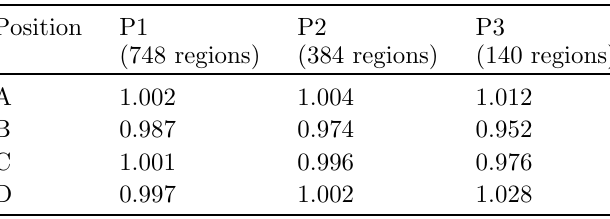
Table 6. Ratio of uncertainties on R i :